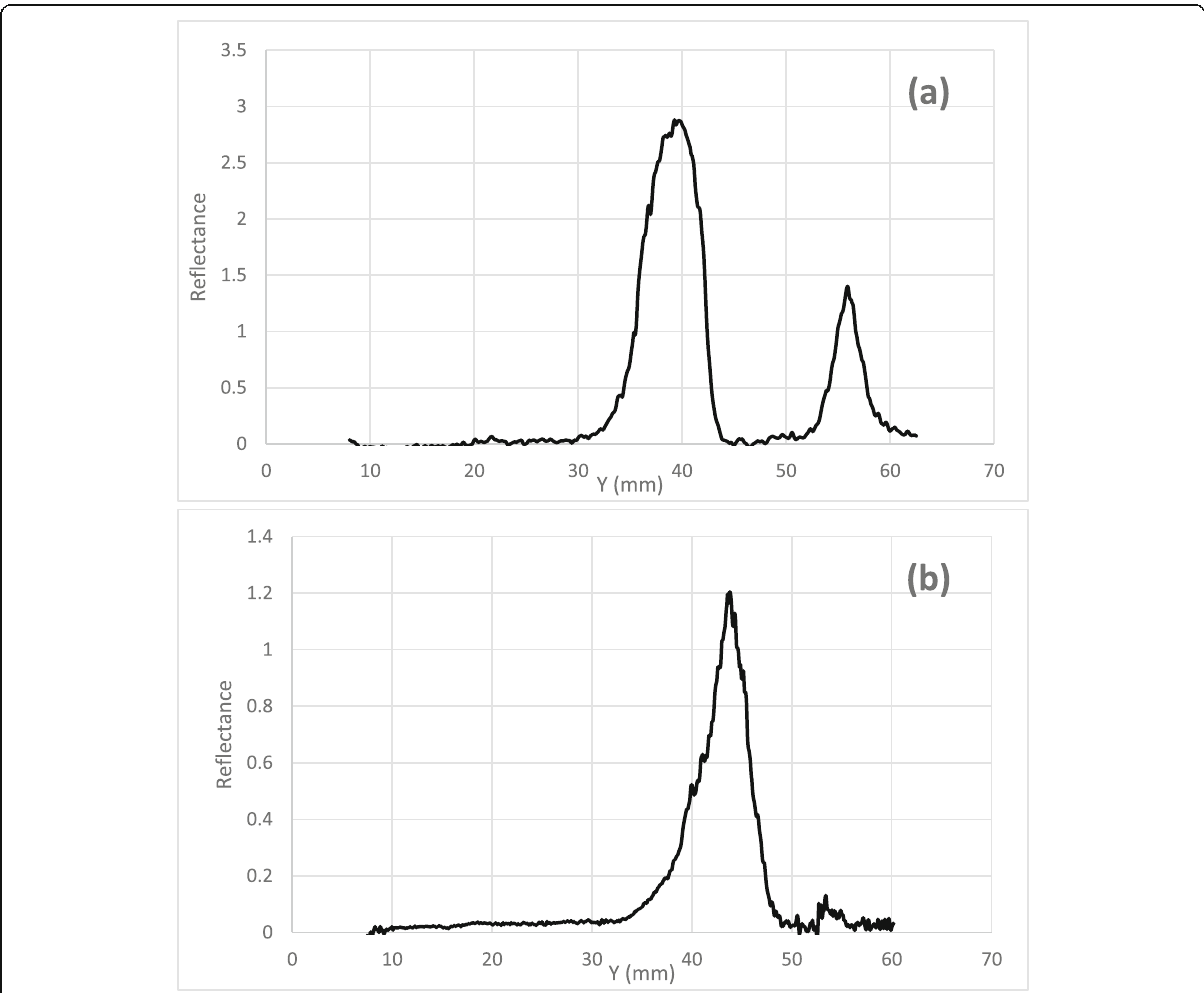
Fig. 7 Densitograms of a nitrophenol and b (±)-ibuprofen mixtures developed on SC-2P TLC plates without copper